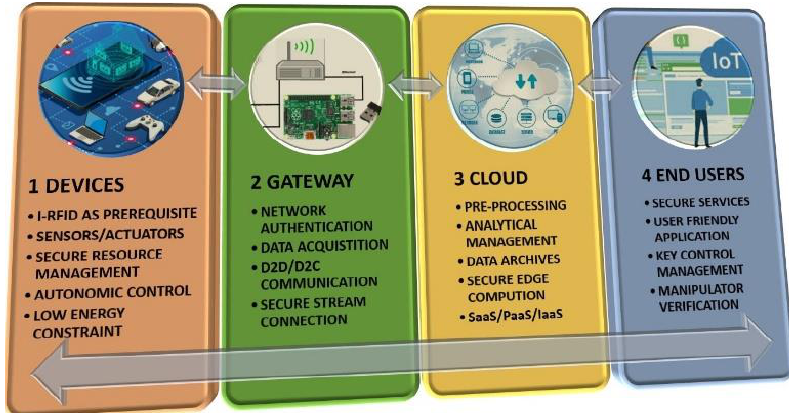
Figure 1. Internet of things (IoT) four-tier architecture for smart X environments. Each tier is linked with each other through internet gateway access. Under this scenario, end users can easily manage and control the devices tier.